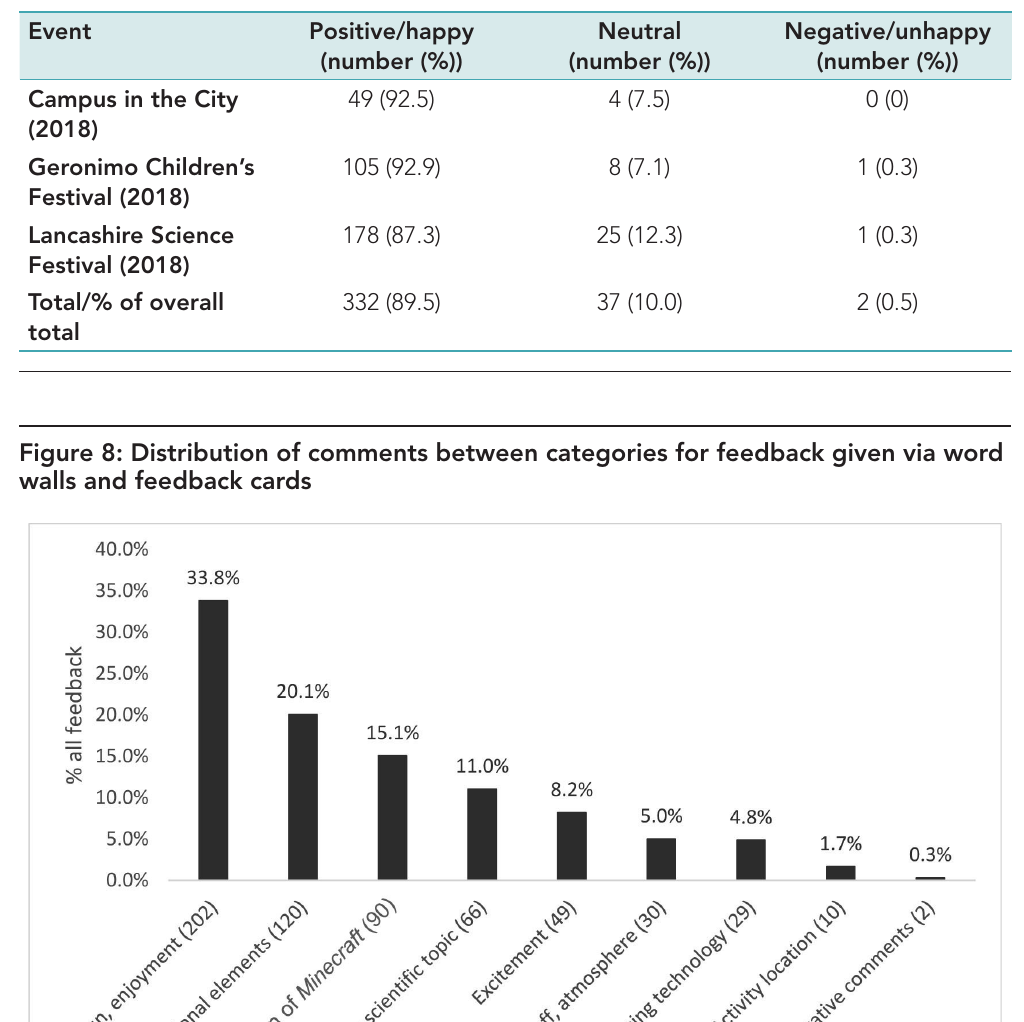
Table 2: Feedback given in 2018 via cards (n=371)